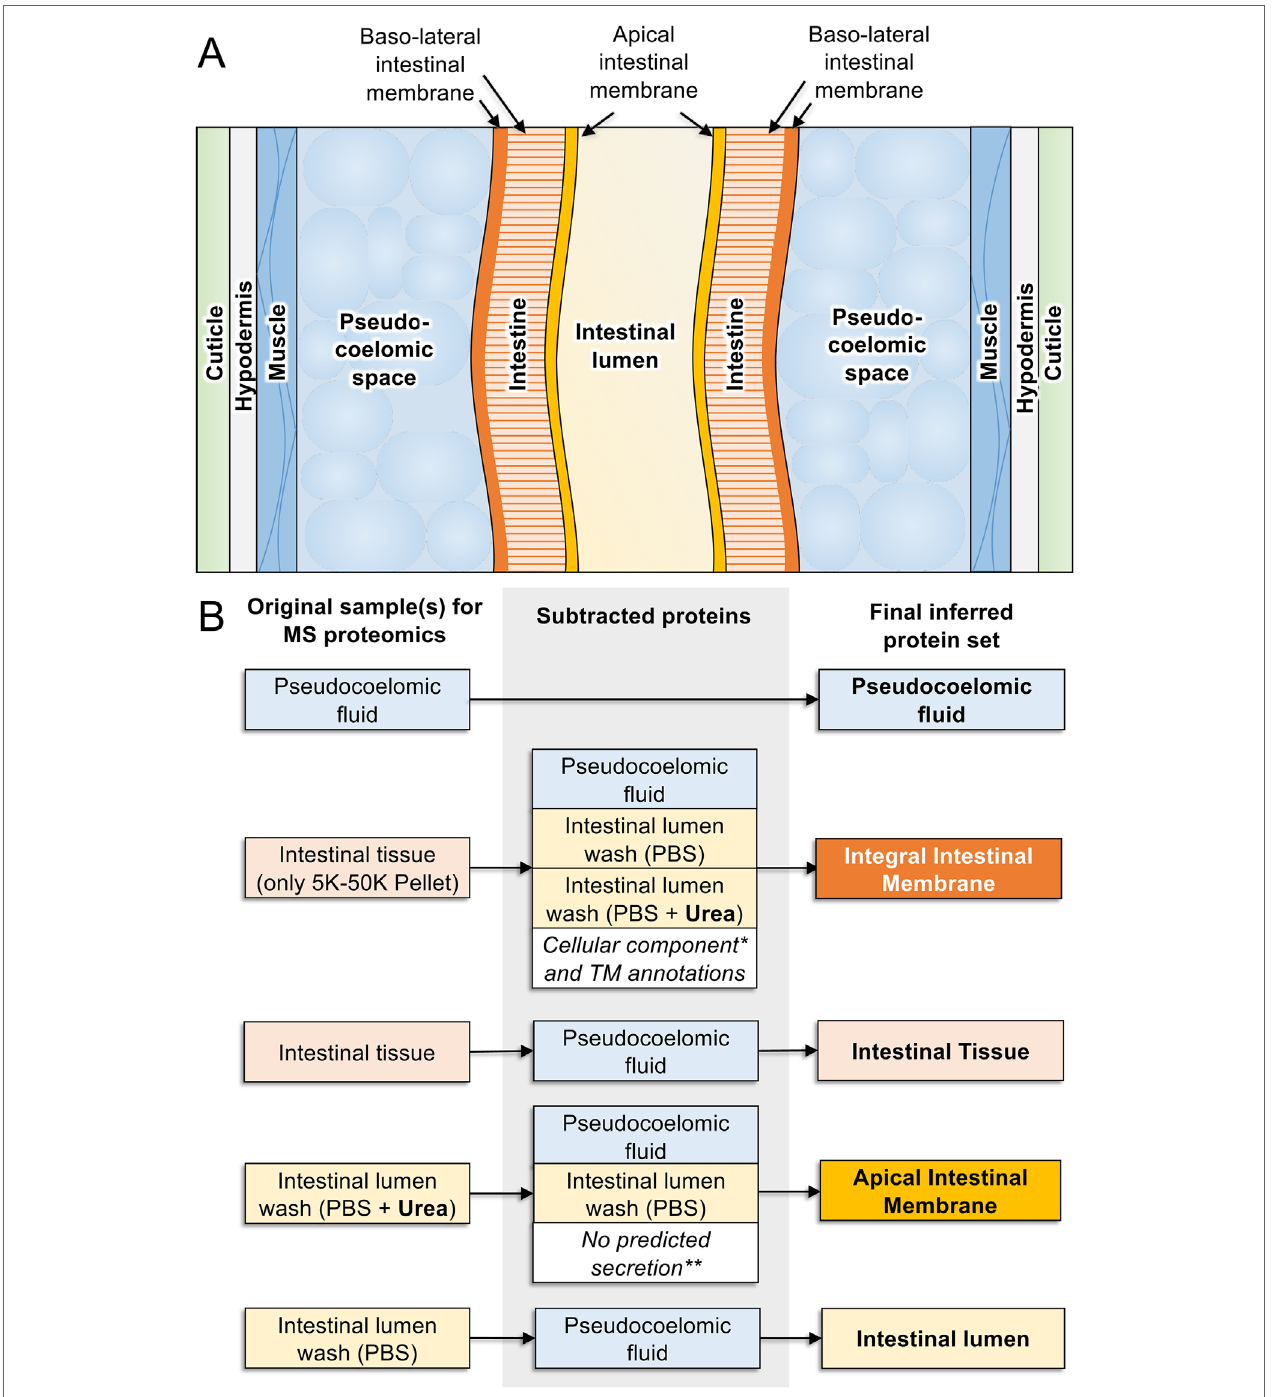
FIGURE 6 | Proteomics-based inference of A. suum intestinal proteins in different compartments. (A) Anatomy of model intestinal nematode species Ascaris suum (transverse section). (B) Protein sets detected by MS/MS proteomics from samples harvested from adult A. suum worms (left) have other protein sets strategically removed (center) to deduce final protein sets in different intestinal compartments (right). “Integral intestinal membrane” proteins are not labelled as “basal” because they may include some proteins from the apical intestinal membrane as well. *Proteins annotated with “cellular compartment” Gene Ontology terms for endoplasmic reticulum, mitochondria, Golgi apparatus, and nucleus were removed to reduce contamination from proteins embedded in these organelles rather than the external cellular membrane. **Only proteins annotated with predicted classical or nonclassical secretion signals were included since these are better candidates for proteins that are transported to the